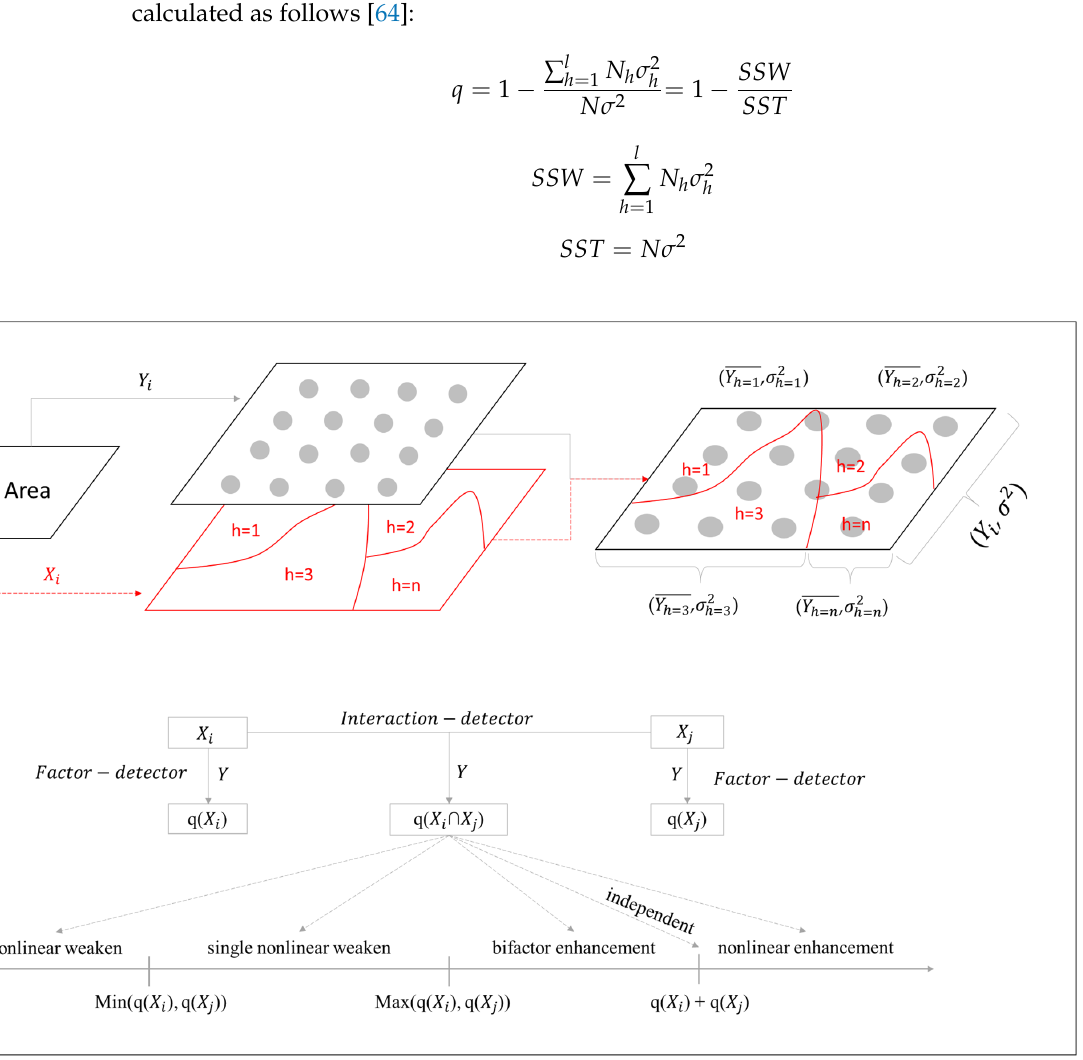
Figure 4. Factor and interaction detector of GeoDetector .